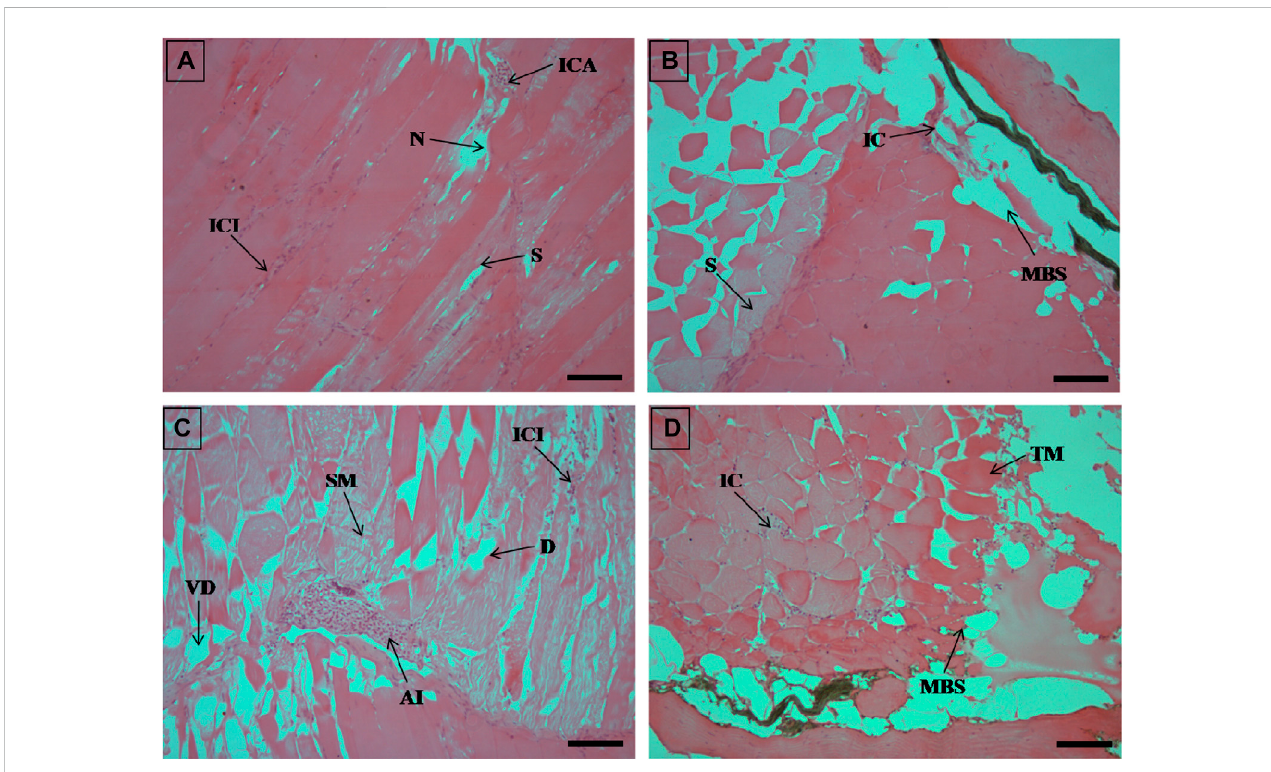
FIGURE 6 The histological sections (4 µm) ofmuscle tissues from EB-administeredgolden mahseer on 21st day (A – D) ofEB-medication.The histologicalchanges in muscle tissues of fi shes fed with EB doses (A) at 50 μ g/kg fi sh/day showing focal area of necrosis (N), splitting of myo fi brils (S), in fl ammatory cells aggregation (ICA), in fi ltration of in fl ammatory cells between the muscle fi bres (ICI); (B) at 100 μ g/kg fi sh/day showing muscular bundles separation (MBS), in fl ammatorycells(IC),splittingofmyo fi brils(S); (C) at250 μ g/kg fi sh/dayshowingdegenerativechangesinmusclebundles (D) ,severemyo fi brilsplitting (SM), in fl ammatory cells in fi ltration (ICI), vacuolar degeneration in muscle bundles (VD), acute in fl ammation (AI); (D) at 500 μ g/kg fi sh/day showing muscular bundles separation (MBS), marked thickening of muscle bundles (TM), in fl ammatory cells between the muscle fi bres (IC). The H&E stained sections are visualized at magni fi cation of ×200 under inverted light microscope (Olympus IX53, Canada). The scale bar value depicted in the right bottom corner (A – D) is 40